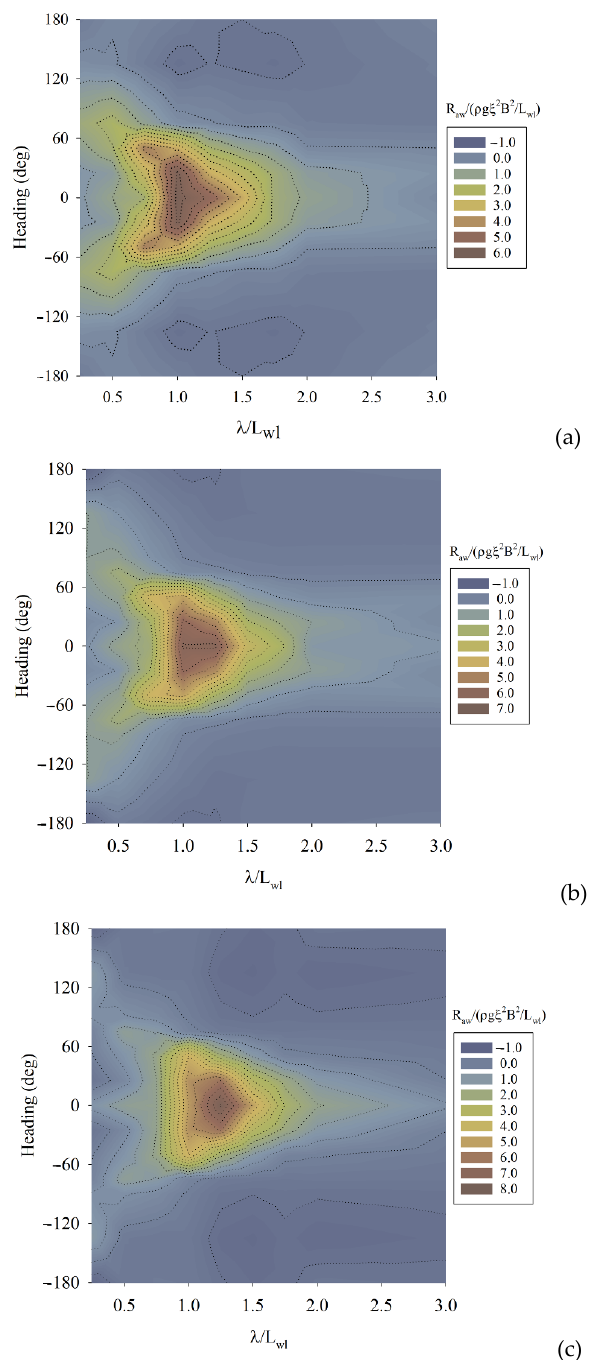
Figure 7. Dimensionless added wave resistance versus different wavelengths versus different wave headings in Load Condition 1. ( a ): Fr = 0.16. ( b ): Fr = 0.20. ( c ): Fr = 0.24. Source: Own elaboration.